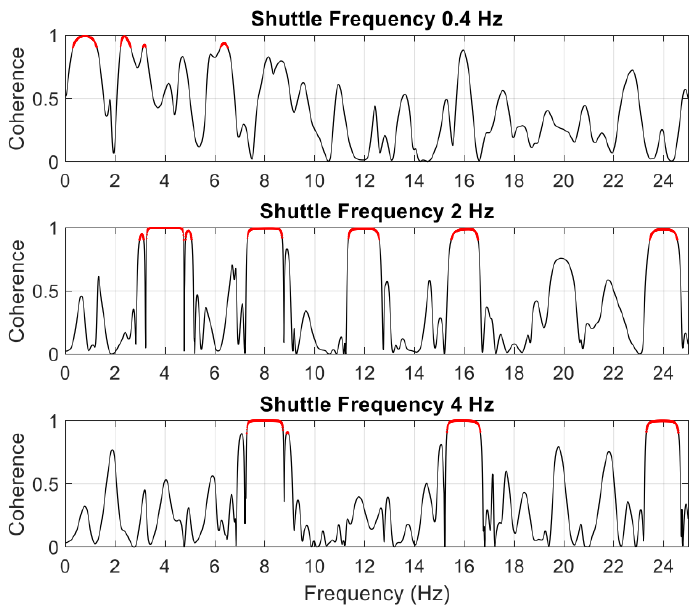
Figure 13. Magnitude squared coherence estimation for three shuttle frequencies. The coherence exceeds 0.9 for red parts of the curves.